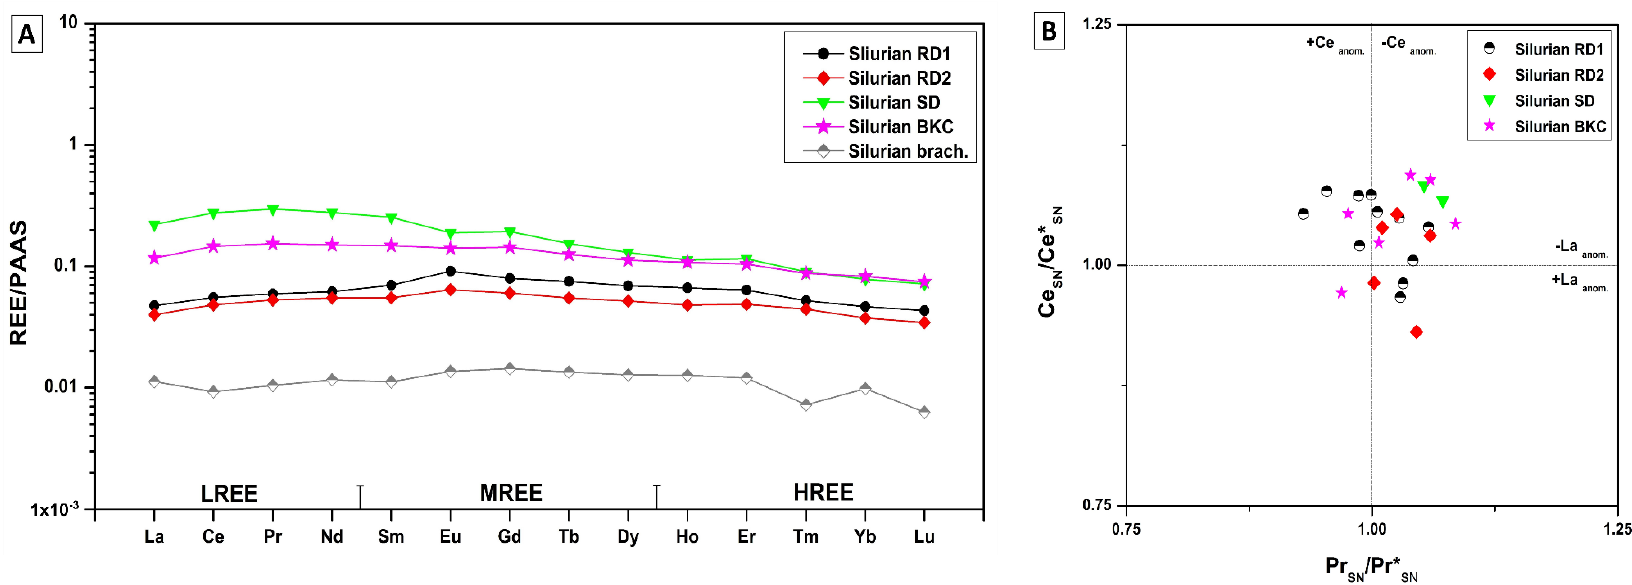
Figure 17. ( A ) Post-Archean Australian Shale (PAAS) normalized rare-earth element (REE) pattern for average values of fine (RD1) and medium (RD2) crystalline dolomite, saddle dolomite (SD) and fracture-filling calcite (BKC) samples, compared with average PAAS normalized REE pattern of well-preserved Silurian brachiopods [54]. ( B ) Ce (Ce / Ce*) SN –La (Pr / Pr*) SN anomaly crossplot of RD1, RD2, SD and BKC samples.